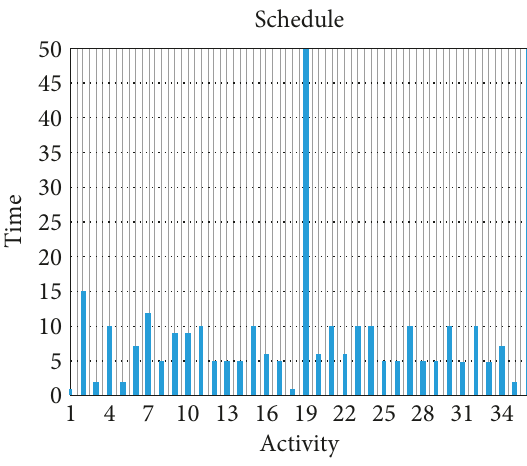
Figure 8: Process portfolio for 280days.